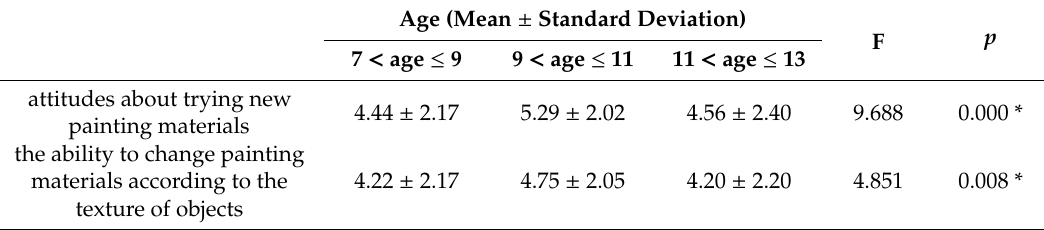
Table 5. The result of children of di ff erent ages to change painting materials according to the texture of objects.